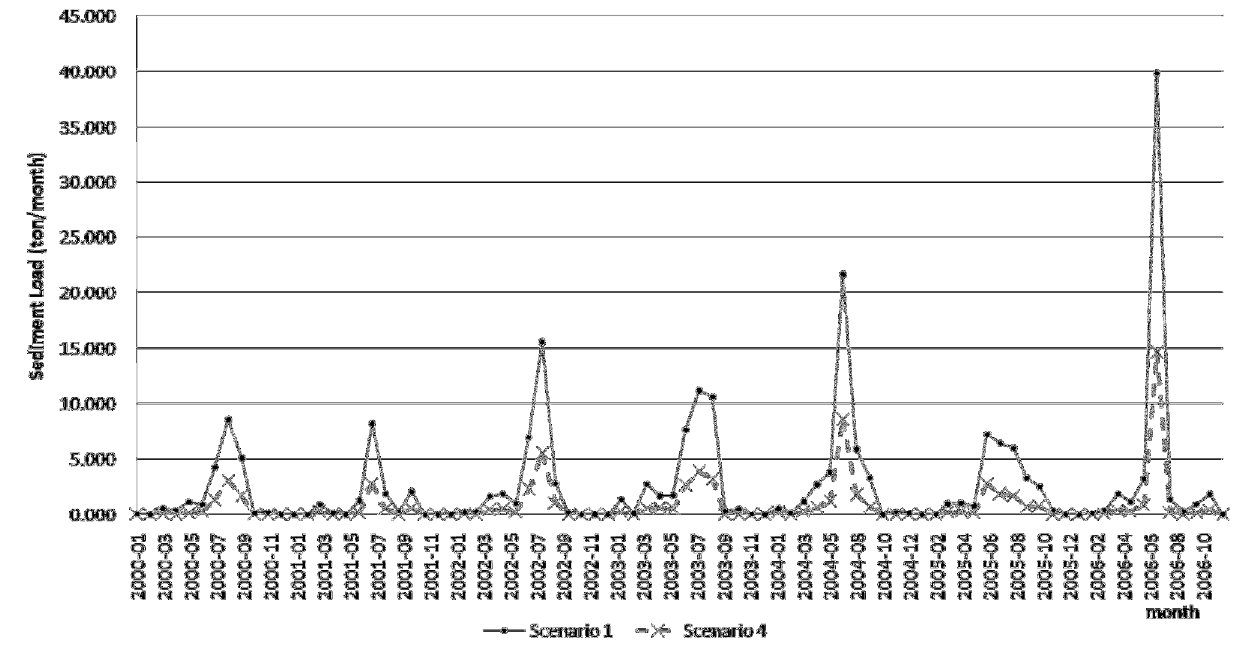
Figure 17. Comparison of Simulated Monthly Streamflow for Scenarios 1 and